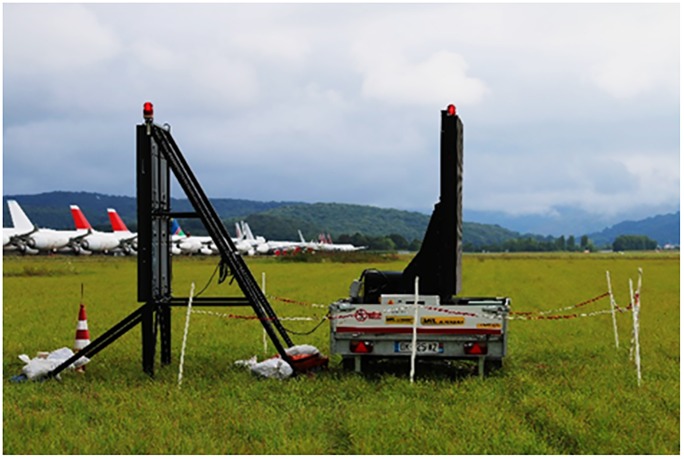
LED screens.The two screens placed back to back on the airport. The basis of both screens was positioned 1m above ground.